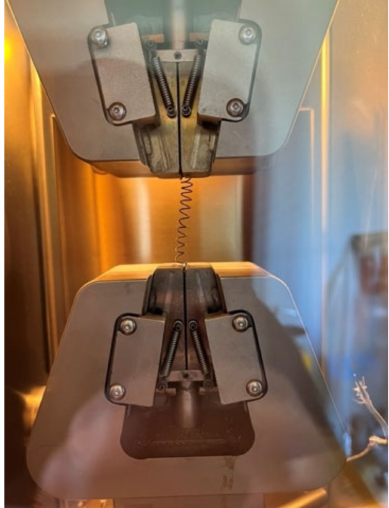
Figure 9. Grips system.